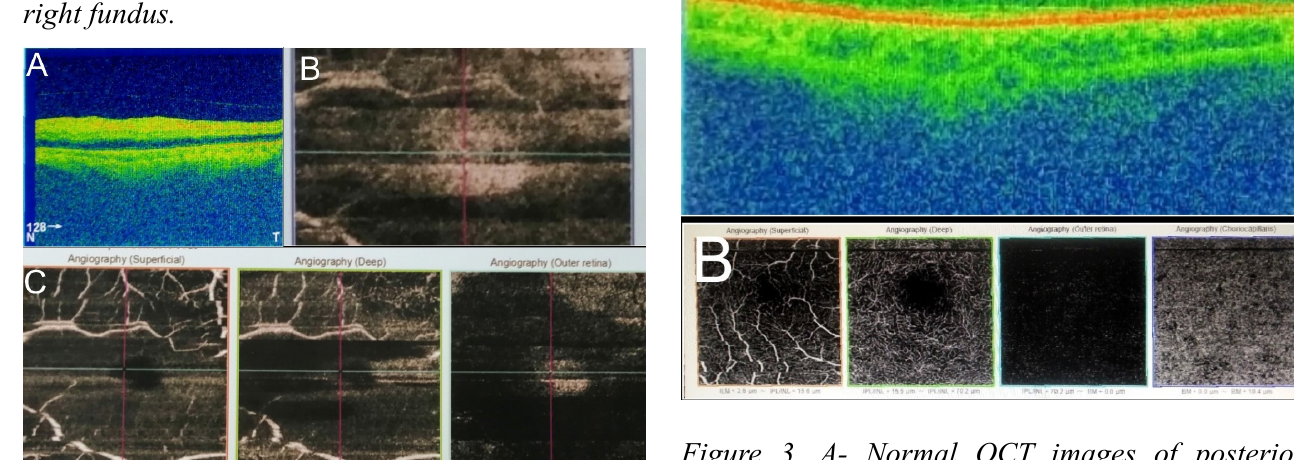
Figure 3. A- Normal OCT images of posterior segment of the right eye. B- Normal OCT-A posterior segment of the right